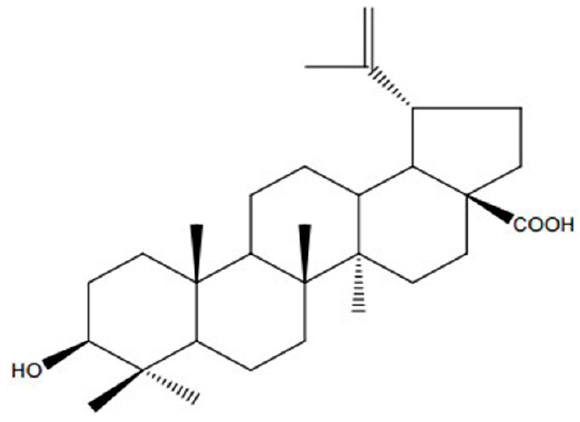
Figure 1. The chemical structure of betulinic acid (BA).